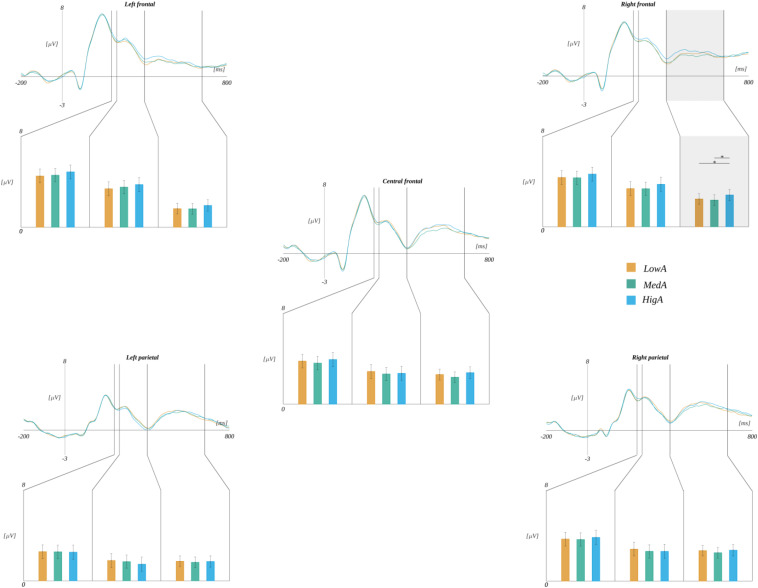
Interaction between regions and arousal. In each panel, the upper plot shows grand average ERP traces for each level of arousal, whilst the lower bar plot displays the average amplitude within each time-window for each level of subjective significance. Error bars mark SEM. Horizontal lines with asterisks mark significant differences (*p < 0.05). Time-windows with significant effects are marked with gray shadings.